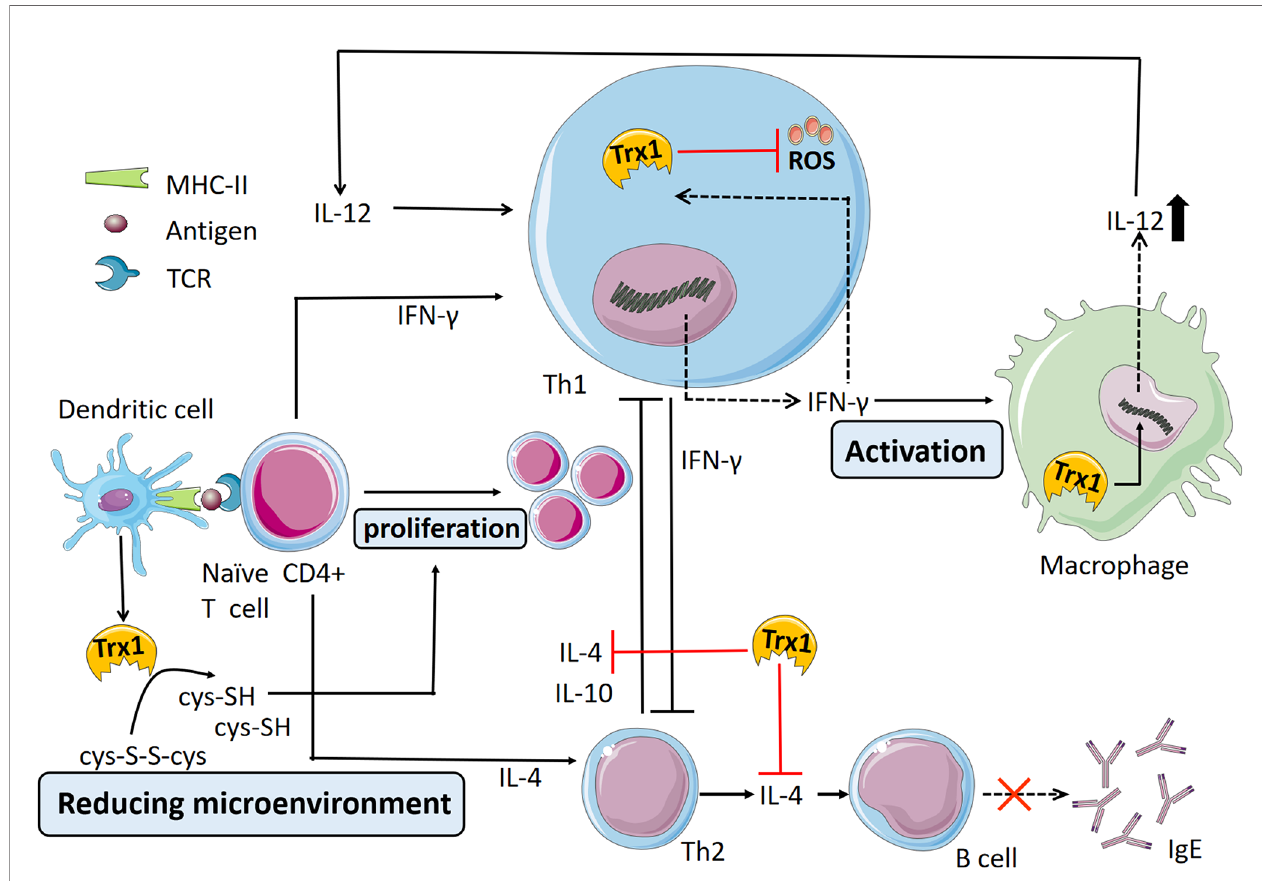
FIGURE 2 | Thioredoxin-1 (Trx1) regulation of Th1/Th2 balance. Most extracellular cysteine (cys-SH) equivalents exist in the oxidized form of cystine (cys-S-S-cys). T cells cannot ingest cystine and rely on antigen-presenting cells (e.g., dendritic cells) to provide cysteine for them. Dendritic cells convert extracellular cystine into cysteine through Trx secretion, thereby promoting the proliferation of activated T cells. A positive feedback mechanism exists between Trx and IFN- g wherein Trx1 induces the expression and release of IFN- g in Th1 cells and the increased IFN- g level increases Trx1 levels in turn. IFN- g -activated intracellular Trx1 of macrophages increases Th1 cytokine IL-12 secretion by regulating the thiol redox state. Furthermore, Trx1 selectively inactivates the cytokine activity of IL-4 and inhibits the Th2 immune